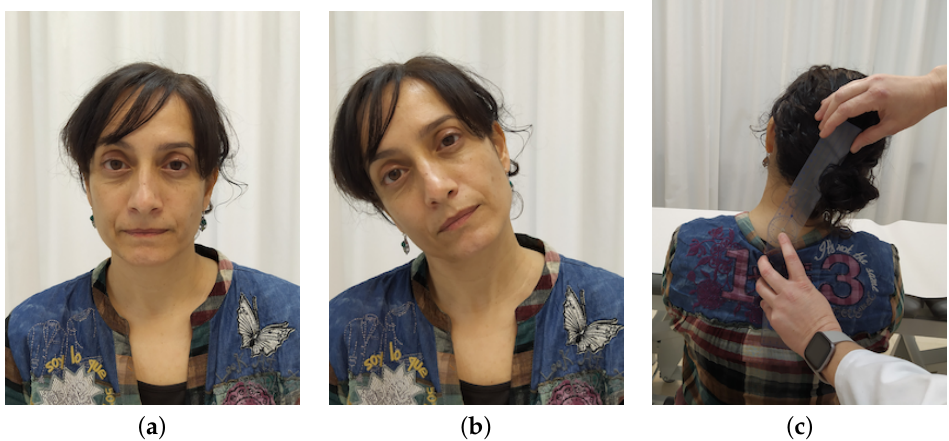
Figure 4. Stages of the experiment procedure: ( a ) participant placed in the initial position, ( b ) partici- pant once the acoustic alert sounded and the participant stopped the movement, ( c ) measurement of the neck ROM of the participant using the goniometer.